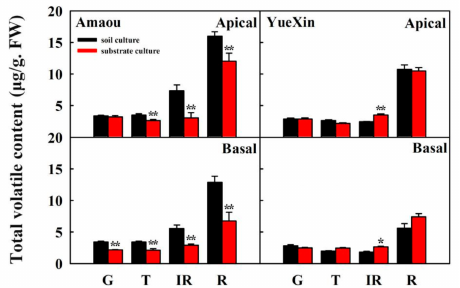
Figure 1. Effects of substrate and soil culture on the fruit total aroma components in two strawberry cultivars. G, T, IR and R represents different fruit development stages, corresponding to green, turning, intermediate red and full red, respectively. Bars indicate means ± SD from three biological replicates. Asterisks indicate significant differences (* p < 0.05; ** p <